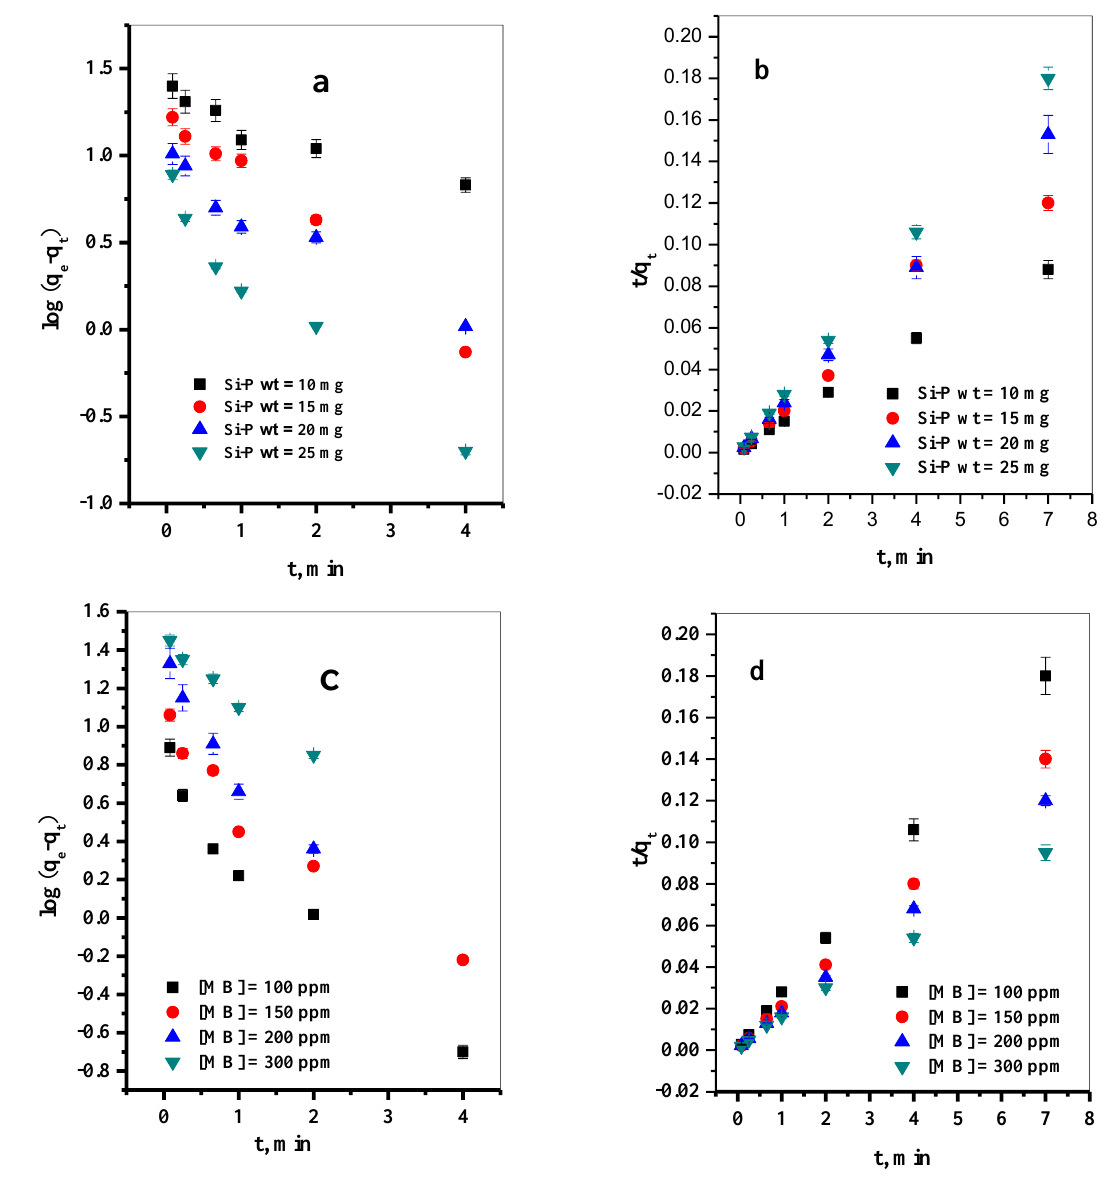
Figure 5. ( a ) Effect of contact time on removal percent of MB dye, ( b ) P@SiO 2 nanocomposite dose on equilibrium constant, ( c ) pseudo-first-order plot, ( d ) pseudo-second-order plot. ([P@SiO 2 ] = 10–25 mg/10 mL, [MB] = 100 ppm, pH = 7, T = 25 ◦ C). By plotting log (q e –q t ) versus t at different pH values of the MB dye solution (Figure 6a,b), Table 1 The calculated parameters of the pseudo -first-order and pseudo -second-order kinetic model for various P@SiO nano- the correlation coefficient (R 2 ), the first-order rate constant (k 1 ), and q e were calculated from 2 the slopes and intercepts of the straight lines and listed in Table 3. Similarly, R 2 , k 2 , and q e composite. related to the pseudo-second-order were calculated from the linear plot of the t/q t versus t at different pH values of the dye solution and recorded in Table 3. By comparing the values of R 2 related to the pseudo-first-order kinetic model with that in the case of the pseudo- second-order kinetic model, it can be observed that the R 2 in the pseudo-second-order kinetic model is higher than in the pseudo-first-order kinetic model. Moreover, the calculated q e value obtained from the pseudo-second-order kinetic model is closer to the experimental q e values. This indicates that the pseudo-second-order kinetic model best describes